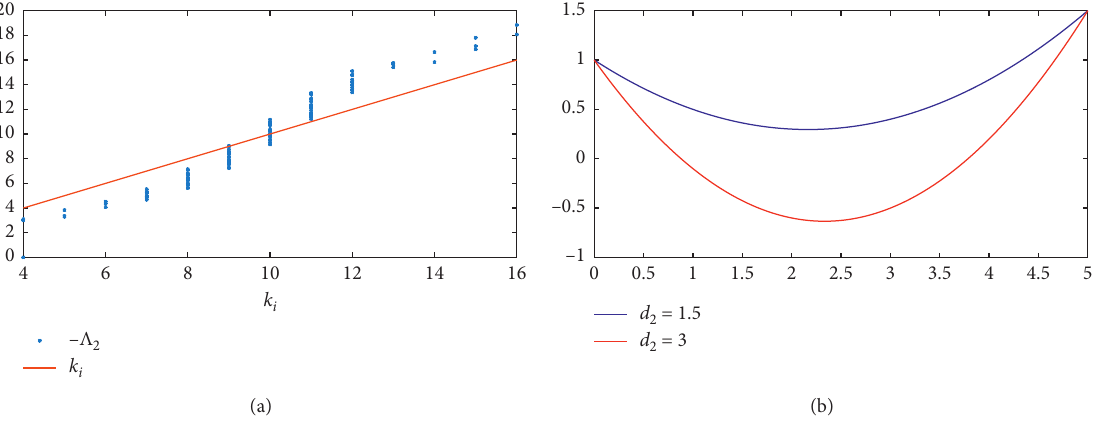
Figure 5: The role of k shown.